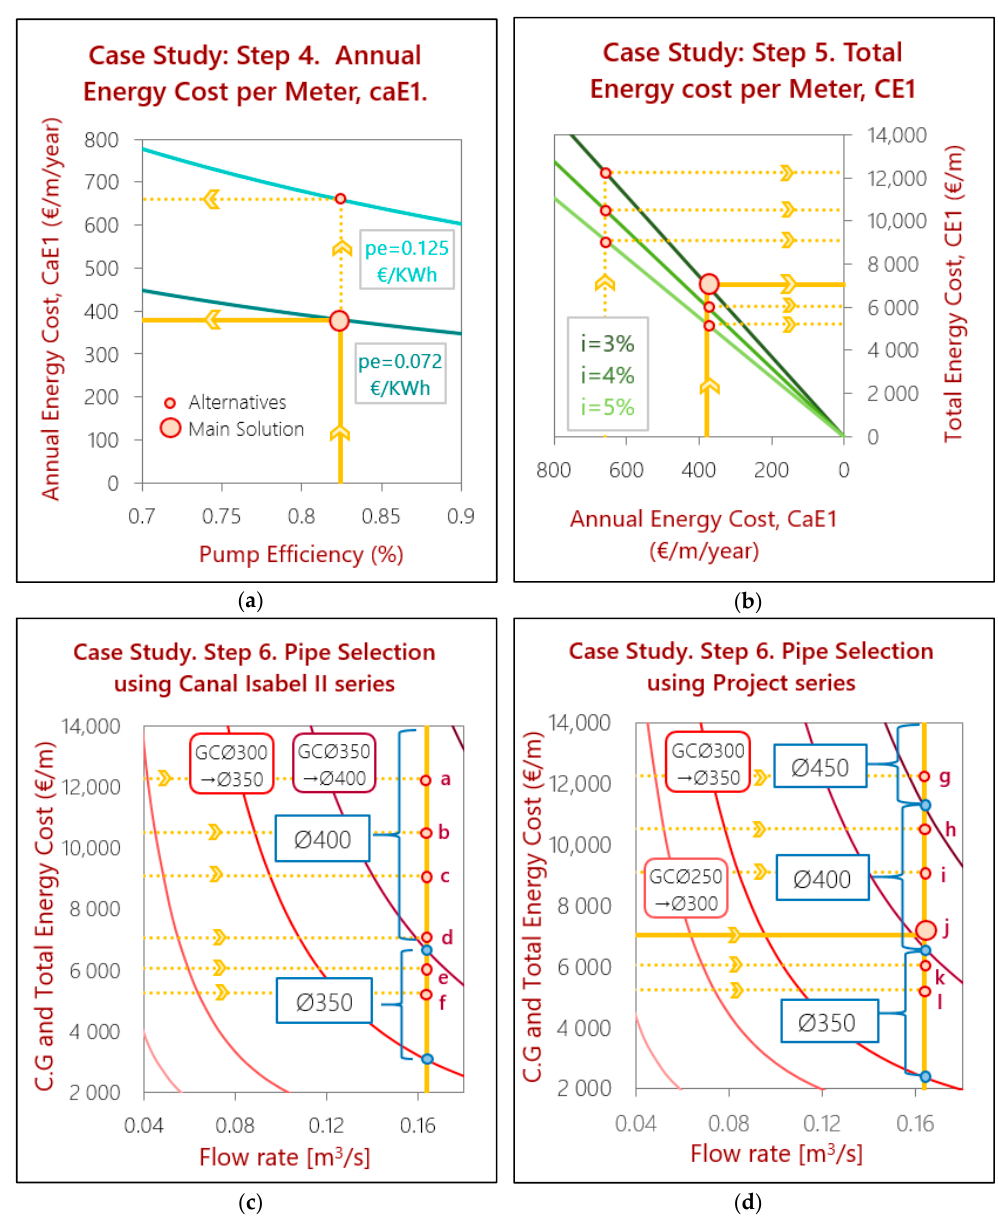
Figure 9. Case study of the Navas del Marqués. ( a ) Step 4: Calculation of the annual energy cost; ( b ) Step 5: Calculation of the capitalized energy cost throughout the entire life of the installation. ( c , d ) Both panels show steps 1 and 5 of the procedure. This means that both the change gradient calculation (red curves) and the pipe selection is shown in the figures. In ( c ), the change gradients are calculated using the Canal de Isabel II commercial diameters, and in ( d ), they used the project data. The big orange circle in ( d ) represents the main solution, whilst the small orange circles represent the solutions for the other alternatives evaluated in the case study. For the main solution, as the energy cost per meter C E1 is greater than CGØ350 → Ø400, it is more convenient to choose Ø400 mm. But because C E1 is smaller than CGØ400 → Ø450, it should not be passed onto Ø450 mm and remain with Ø400 mm. The same reasoning applies to the other solution alternatives.